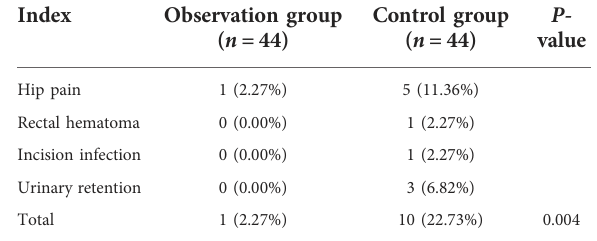
TABLE 4 Comparison of the POP-Q score between two groups. TABLE 6 Complications of patients after